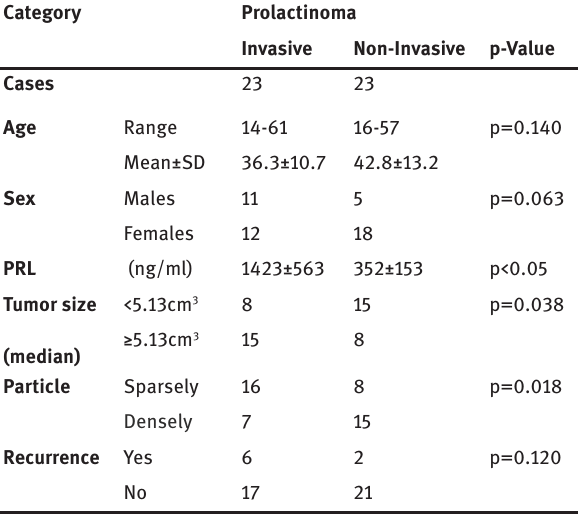
Table 1: The clinicopathological data in 46 prolactinomas